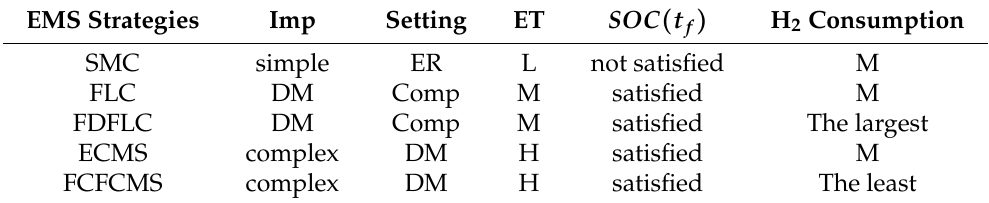
Table 5. Comparative table of the characteristics of the SMC, FLC, FDFLC, ECMS, and FCFCMS